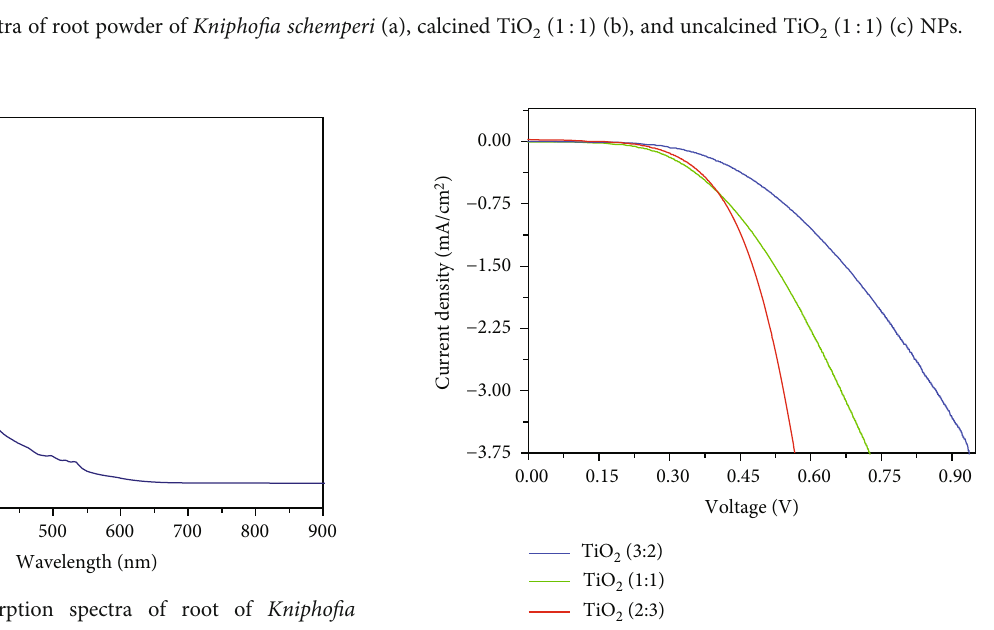
(1 :1) (b), and uncalcined TiO 2